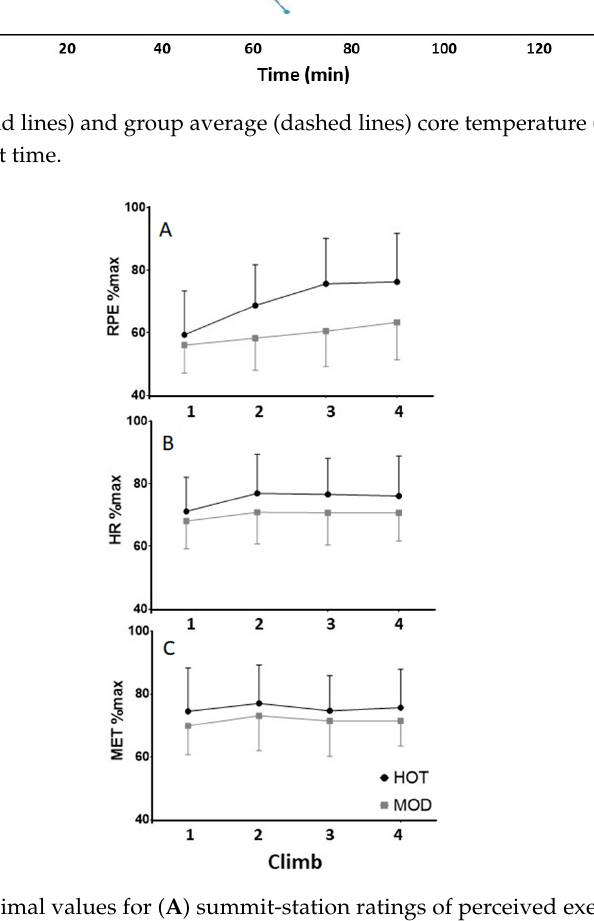
Figure 2. Percent of maximal values for ( A ) summit-station ratings of perceived exertion, ( B ) heart rate, and ( C ) work rate, during each climb.